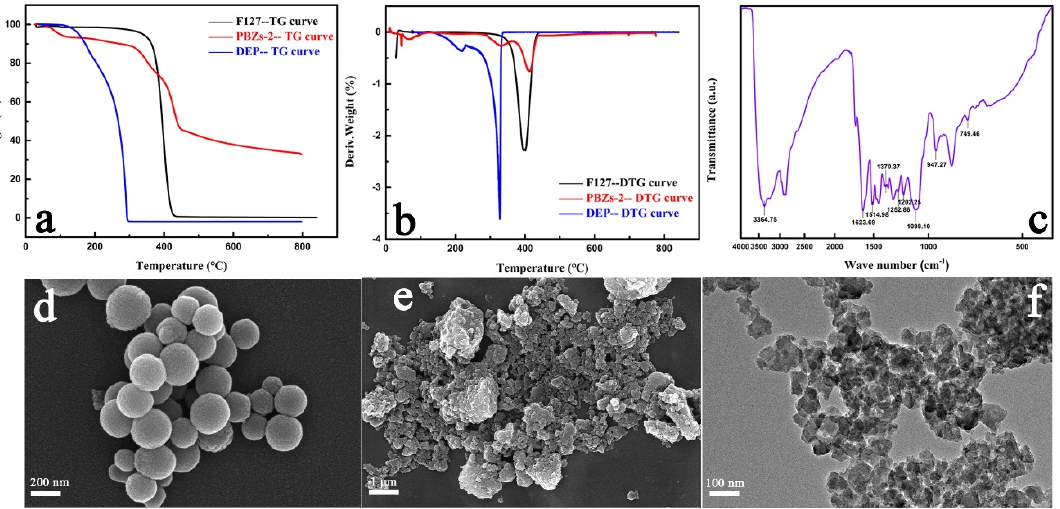
Figure 4. The TG curves ( a ) and corresponding DTG curves ( b ) of F127, DEP and PBZs-2, the FTIR spectrum ( c ) and SEM images ( d ) of colloidal PBZs-2 and the SEM ( e ) and TEM images ( f ) of MCNs without acid curing procedure.